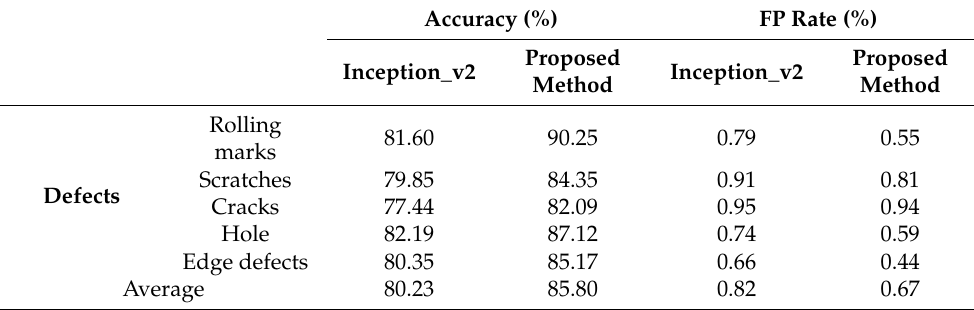
Table 7. Comparison of defect recognition